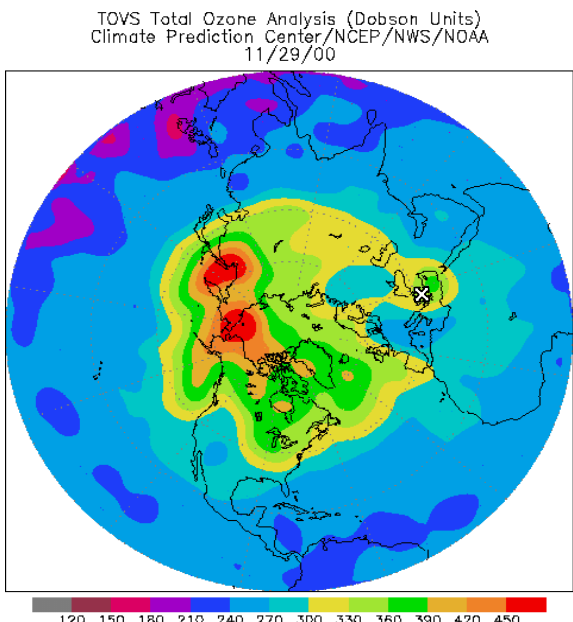
Fig. 4. The TOVS total ozone map (in DU) over Europe on 29 November 2000 at 12:00 UT (Thessaloniki is marked by X).